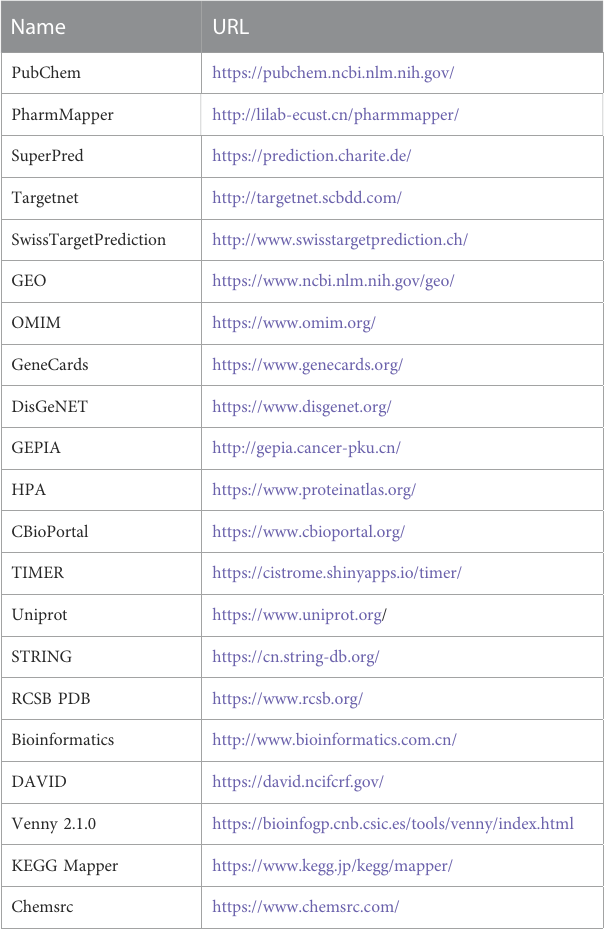
TABLE 1 Basic information of the database used for the screening of curcumin in the treatment of colon